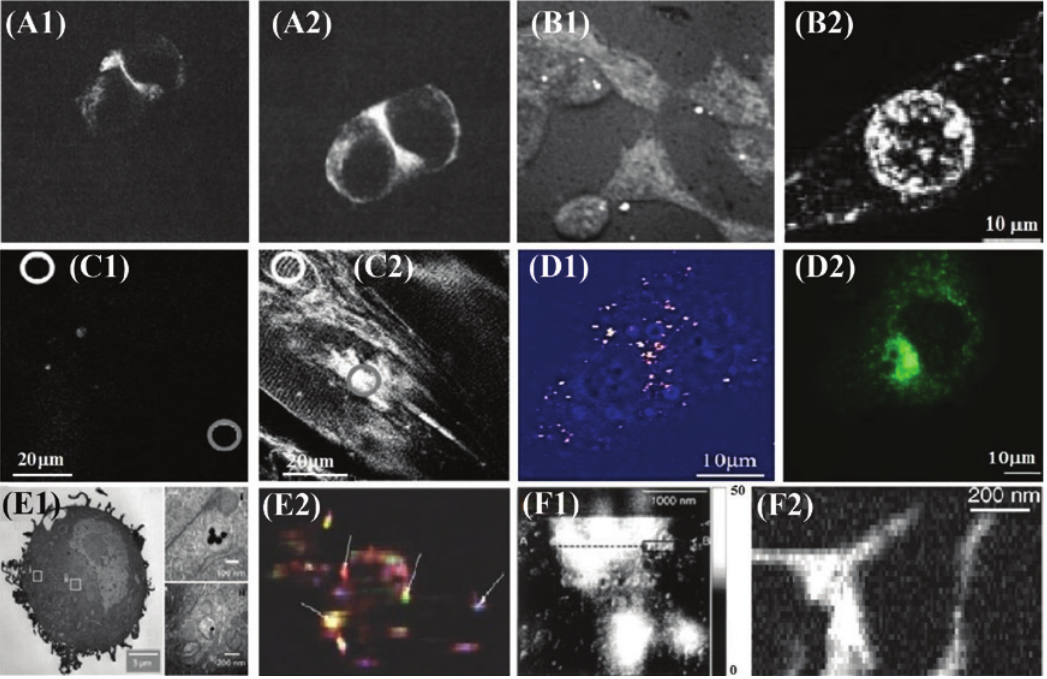
Figure 2: Plasmonics enhanced nonlinear biological